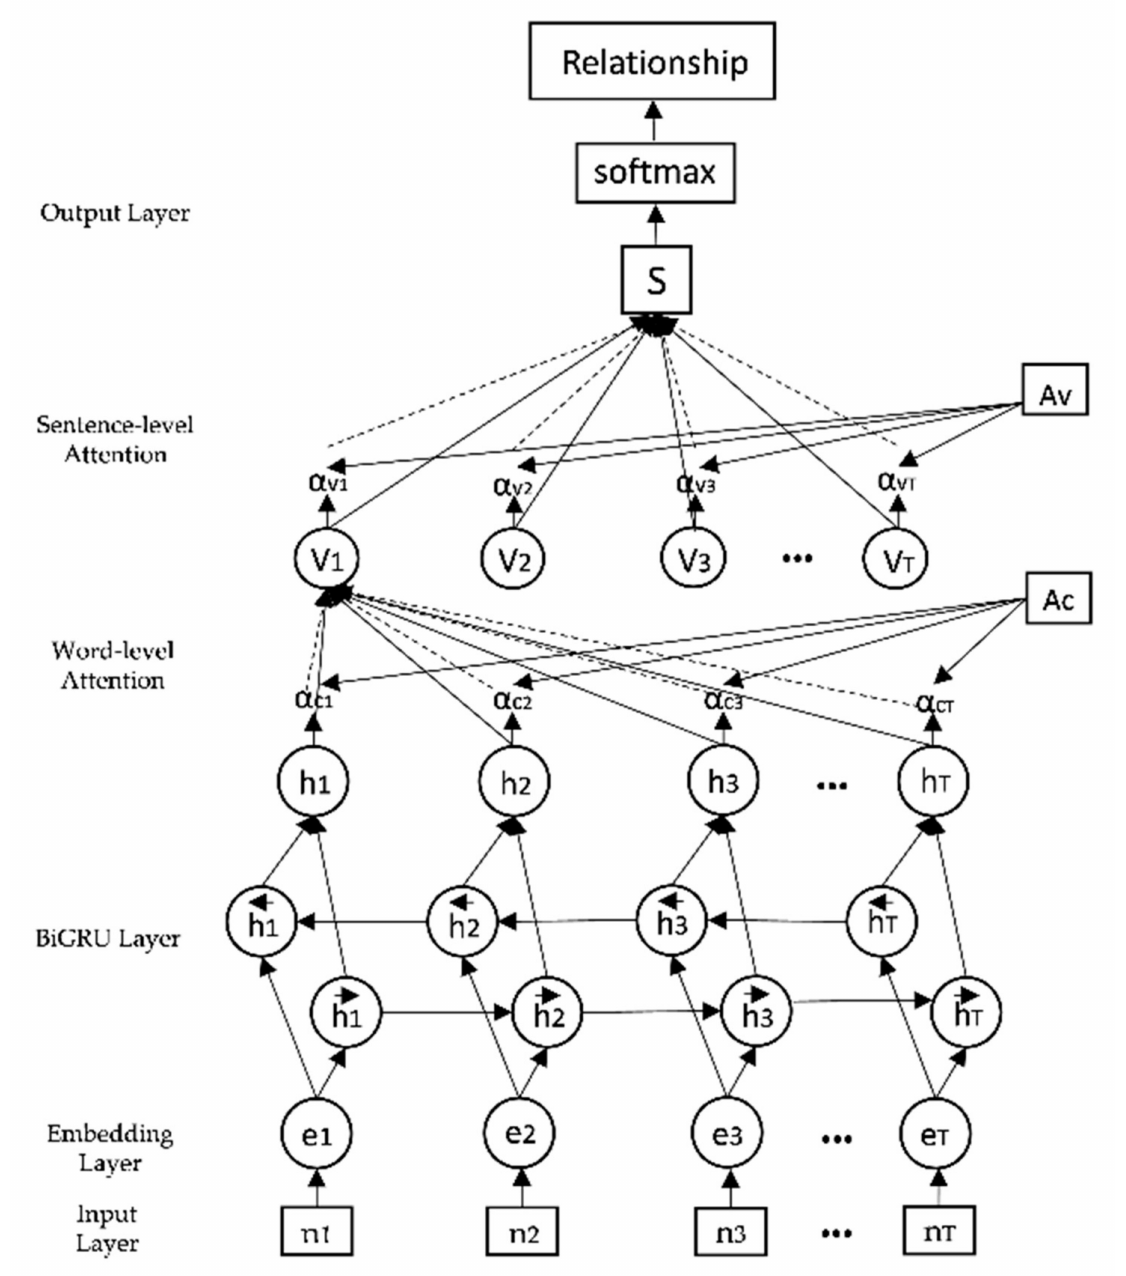
Figure 4. Bidirectional Gated Recurrent Units with Dual Attention (BiGRU-Dual Attention)